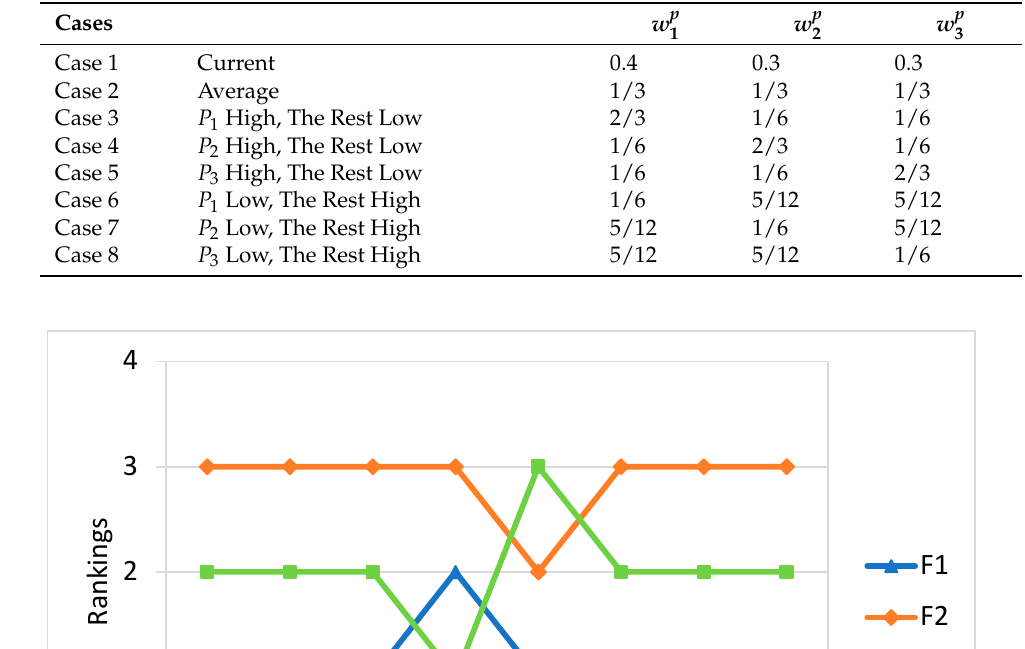
Table 19. The case combinations with different expert weights.